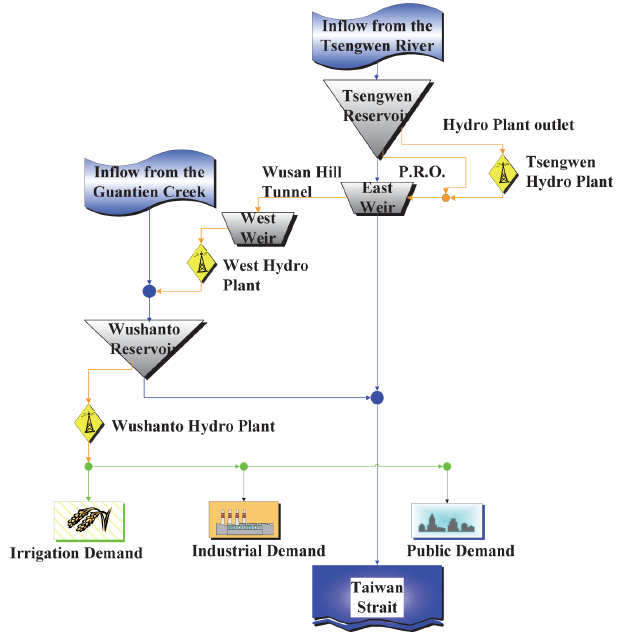
Figure 2. Network of the joint operating system of Tsengwen and Wushanto